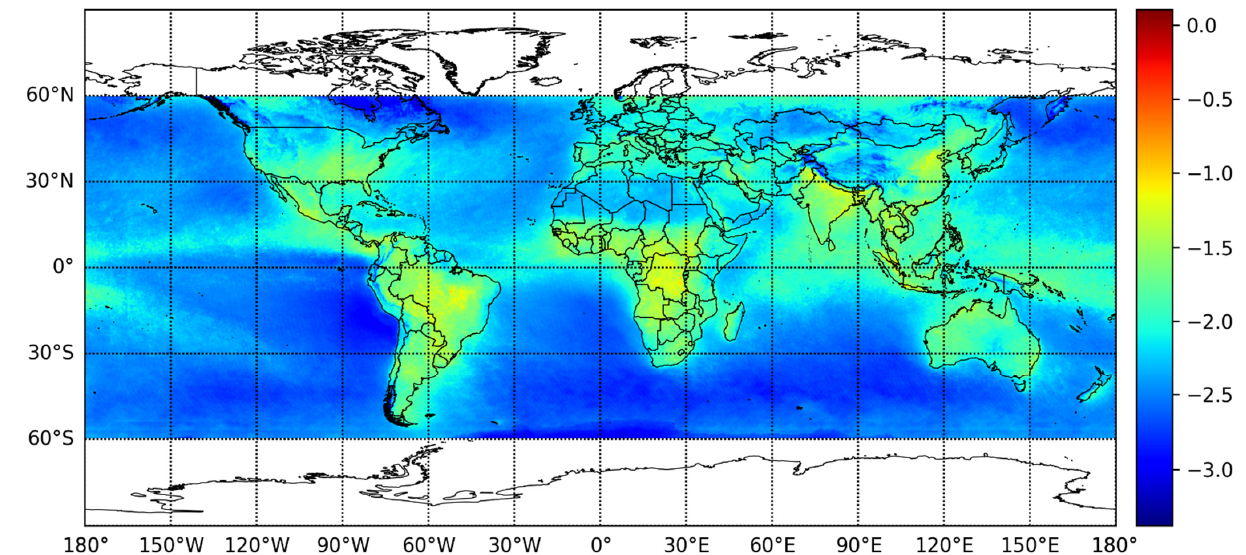
Figure 2. The natural logarithm of global vertical column density (VCD) of HCHO in 2019, after being interpolated and averaged on an annual basis. (unit: mol/m 2 ).